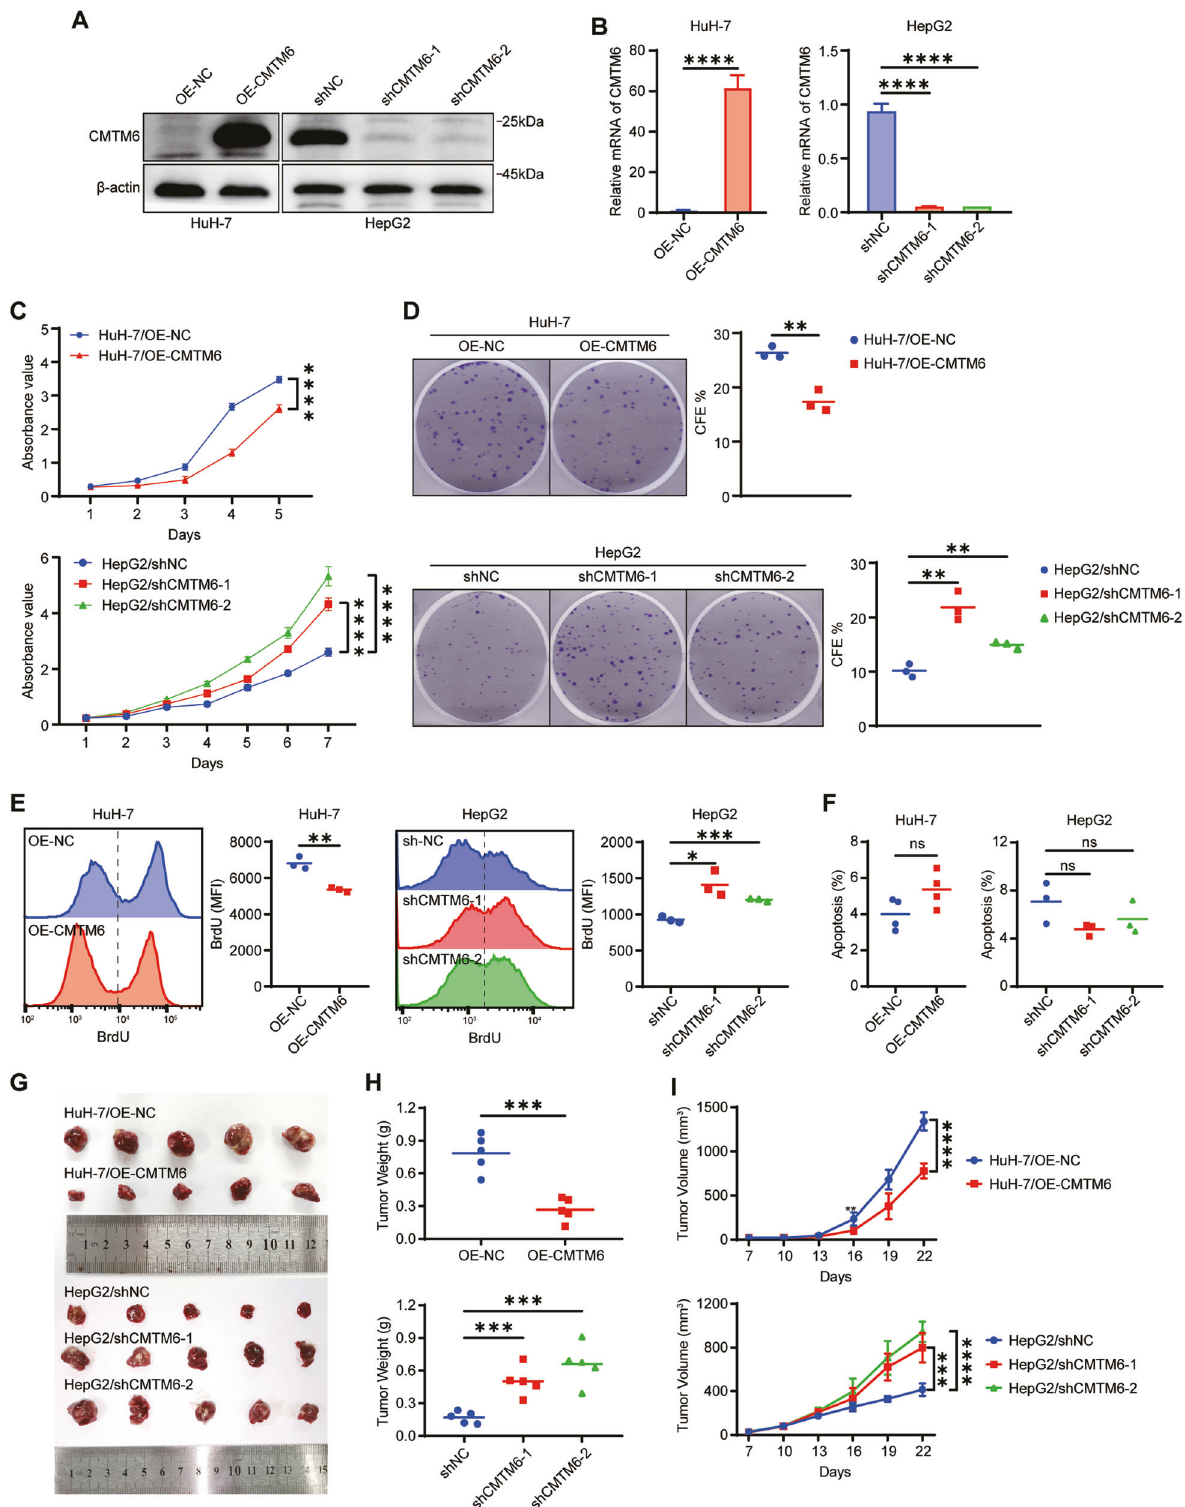
Fig. 2 CMTM6 suppresses HCC tumor growth in vitro and in vivo. A Western blot and B qPCR analysis results validated the regulation of CMTM6 in HuH-7 and HepG2. C CCK-8 assay and D colony-formation assay showing the cell growth of the indicated HCC cells. E Evaluation of the effects of CMTM6 on HCC cells proliferation by BrdU incorporation analysis. F Effects of CMTM6 on cell spontaneous apoptosis as assessed by fl ow cytometric analysis. G Images of the dissected tumors from the nude mice. H The tumor weight of each group is shown. I The tumor growth curves of each group are shown. All in vitro experiments were performed in triplicate. The error bars represent the mean ± SD. * P < 0.05; ** P < 0.01; *** P < 0.001; **** P < 0.0001; ns means non-signi fi cant.